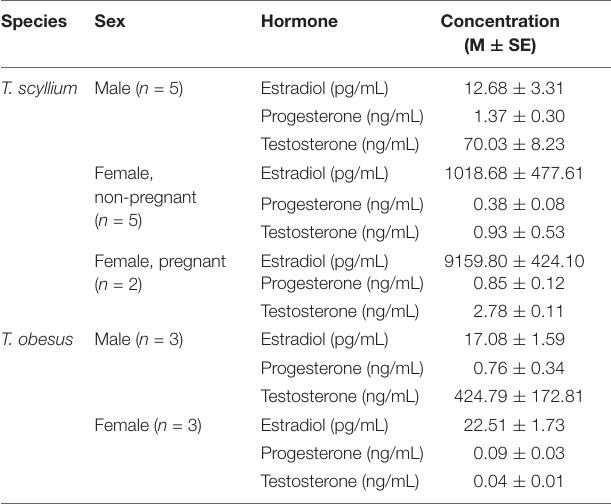
TABLE 1 | Hormone concentrations of Triakis scyllium and Triaenodon obesus prior to Ovaprim R (cid:13) administration.